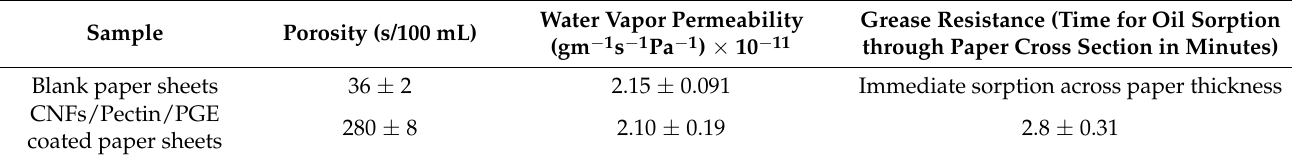
Table 9. Effect of CNFs/20% Pectin/PGE coating on the physical properties of paper sheets.